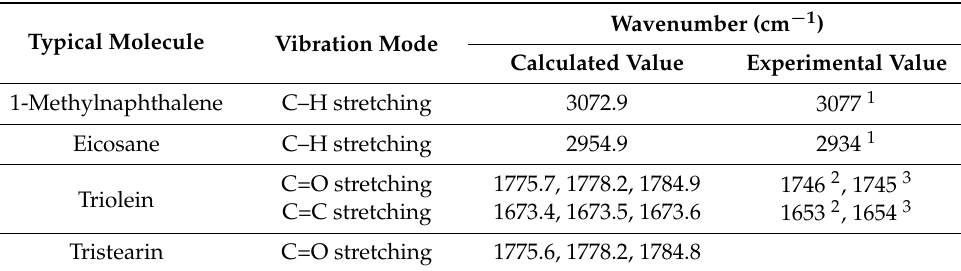
Table 2. Wavenumber of functional